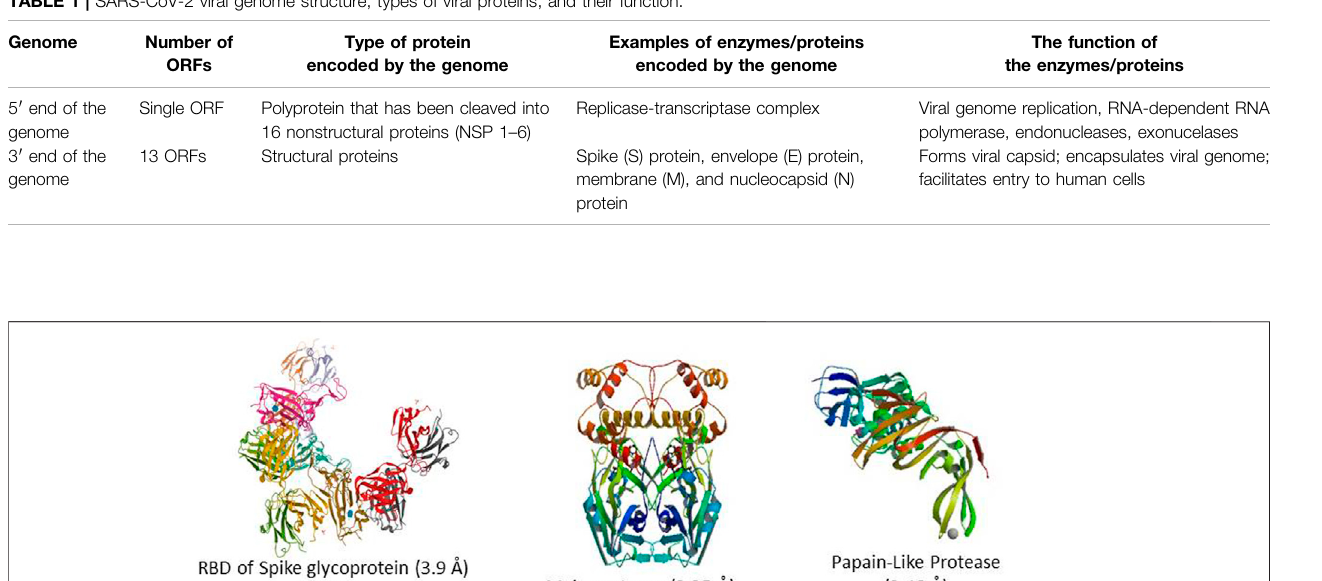
Frontiers in Pharmacology |